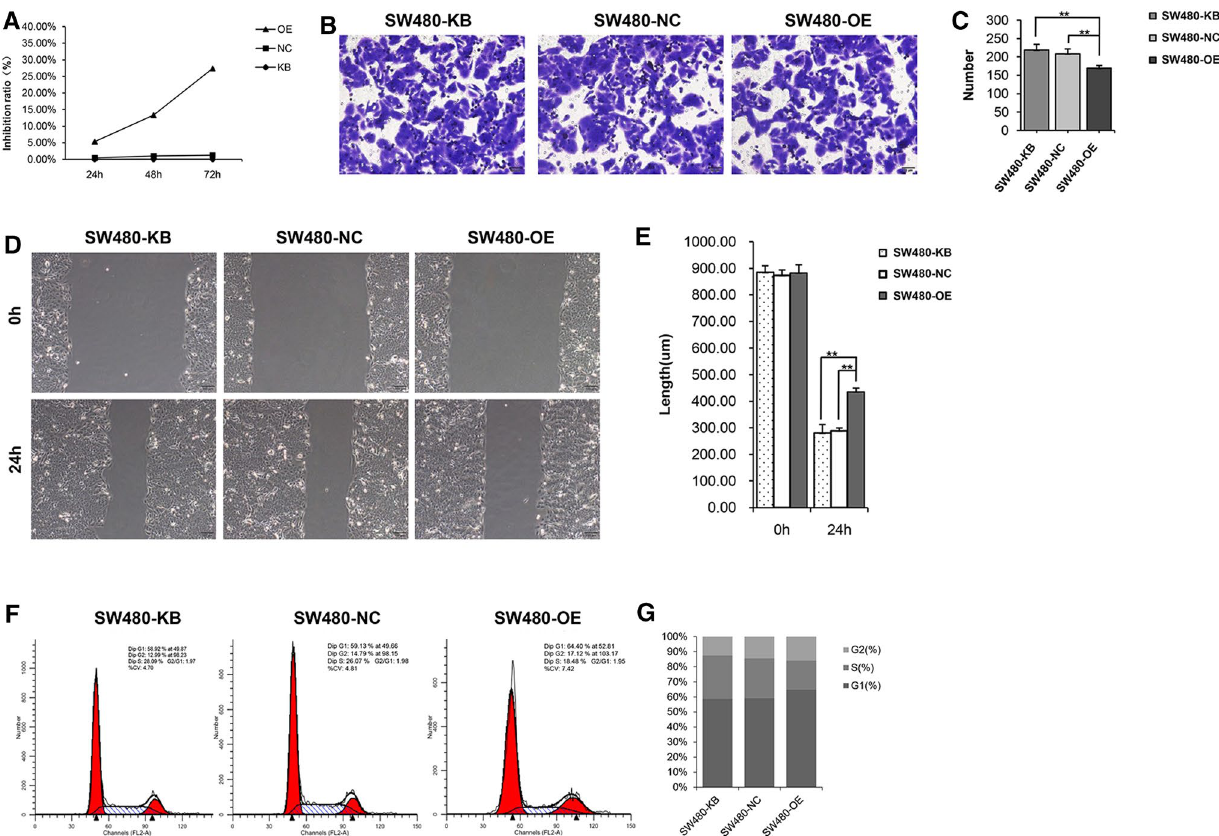
Fig. 3 ORF3a inhibited cell viability and blocked cell cycle progression. A Cell proliferation of the blank group, control group, and ORF3a high expression group was compared. B , C Invasion of CRC cells. There was no significant difference between the blank and control groups (P > 0.05). There were statistically significant differences between the high expression group and the blank group and between the high expression group and the control group (**P < 0.001). D , E The migration length of cancer cells in the high expression ORF3a group was shorter (**P < 0.001), while the migration length of cancer cells in the blank group and the control group was longer (P > 0.05). F , G Cell cycle was detected using PI